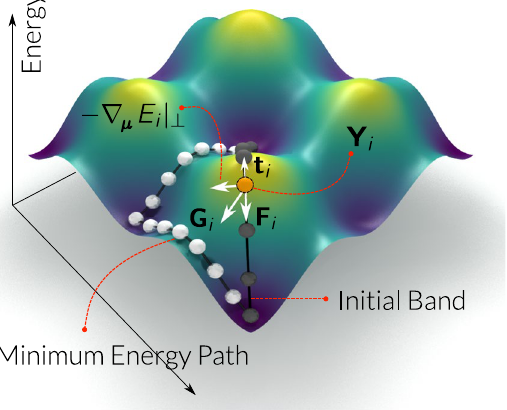
Figure 2. Overview of the NEB method. A summary of the Nudged Elastic Band method in a system parametrised by two variables. The surface height indicates the energy plotted for all points in this two- dimensional phase space. A set of specific magnetic configuration is shown through spheres, each being one image of the method. For a particular image Y i of the initial energy band, we show the effective (total) force G , the gradient component perpendicular to the band ∇ μ E | ⊥ ( μ = μ s s as the magnetic moment, see Methods for details), the tangent to the band t and the spring force F . The height of the surface E i = E ( Y i ) shows the energy of image i . At the extrema of the band, the magnetic configurations are fixed and localised at energy